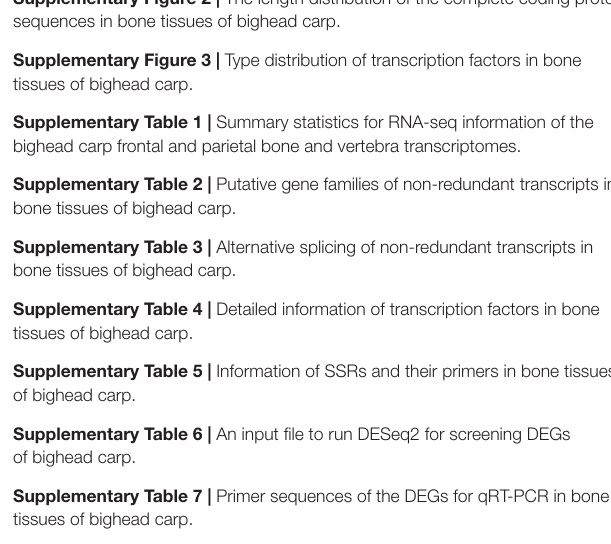
Supplementary Figure 1 | KOG classification of non-redundant transcripts in bone tissues of bighead carp. Supplementary Figure 2 | The length distribution of the complete coding protein sequences in bone tissues of bighead carp. Supplementary Figure 3 | Type distribution of transcription factors in bone tissues of bighead